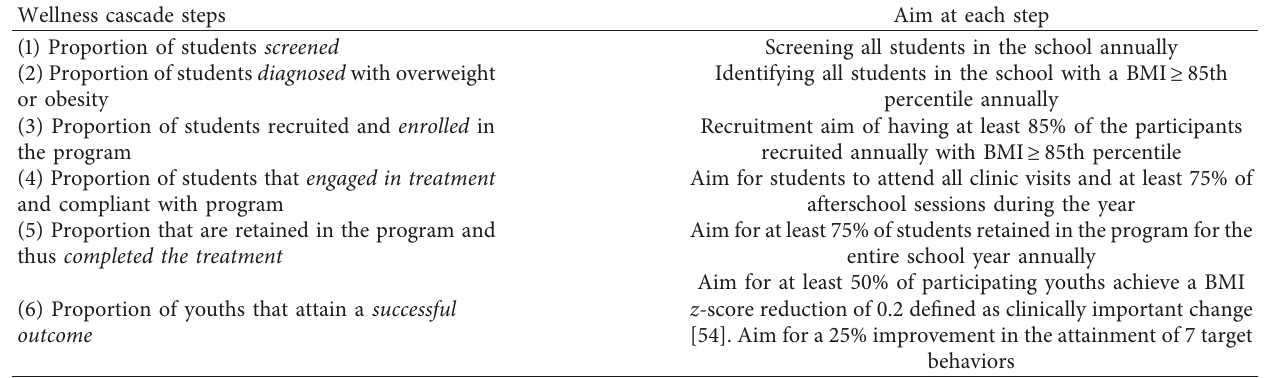
Table 3: Implementation outcome metrics: Wellness